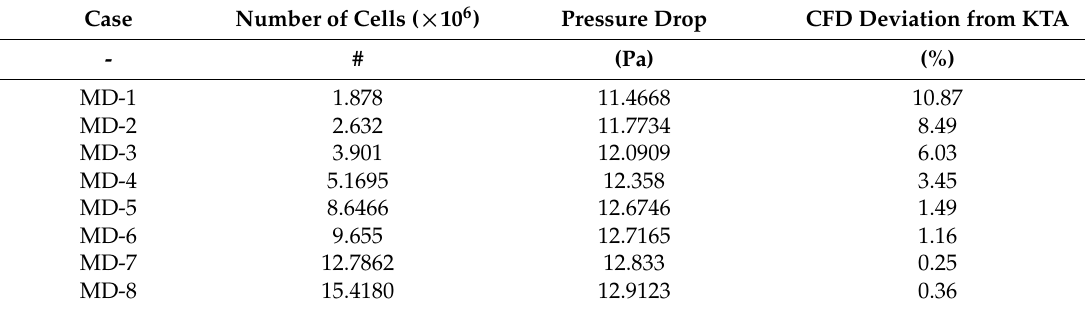
Table 9. The description and results of the mesh independency (MD)